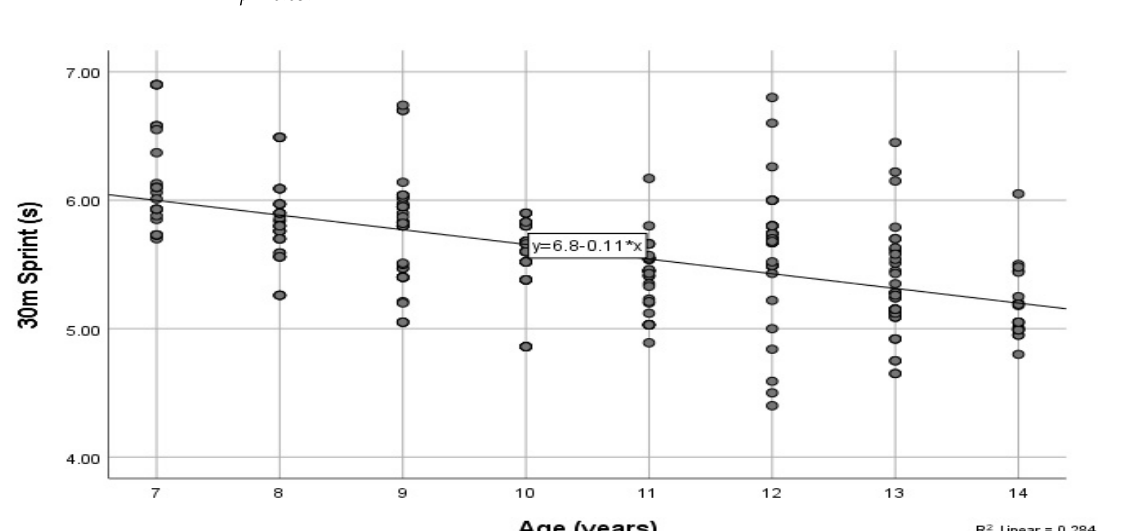
Figure 1. A scatter plot and the corresponding regression line for the relationship between the dependent variable, 30-m sprint (s), and the independent variable chronological age (years.).